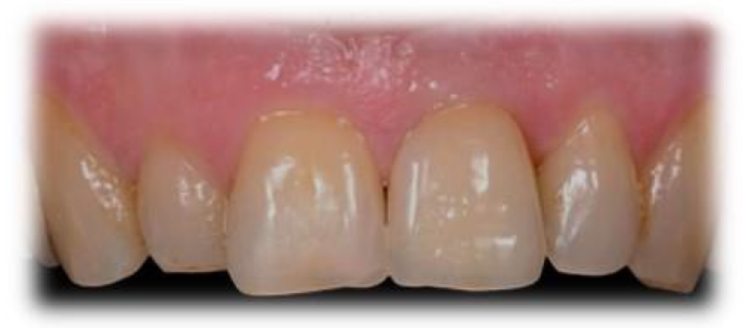
Figure 4. Tooth number 21, 59-month follow-up: PES = 9, WES = 9.